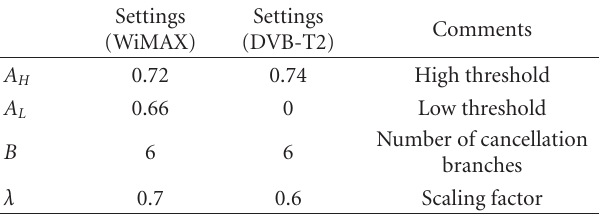
Figure 10: CCDF plots of a DVB-T2 signal before and after PAPR reduction. Table 1: The key parameter settings in TTPS-TR.